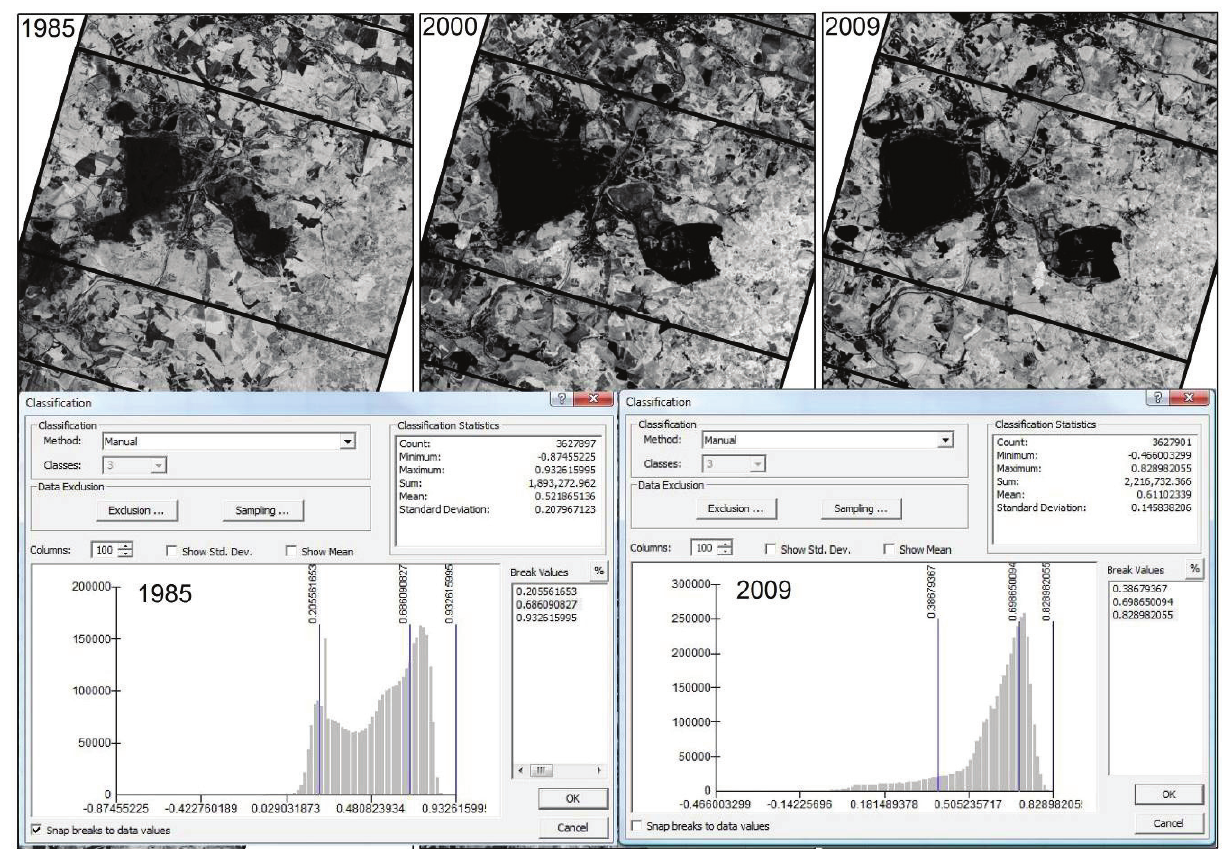
Figure 11. NDVI magnitudes for the Landsat strips for 1985 and 2009 complemented by histograms that show setting the quantiles based on CORINE Land Cover data from